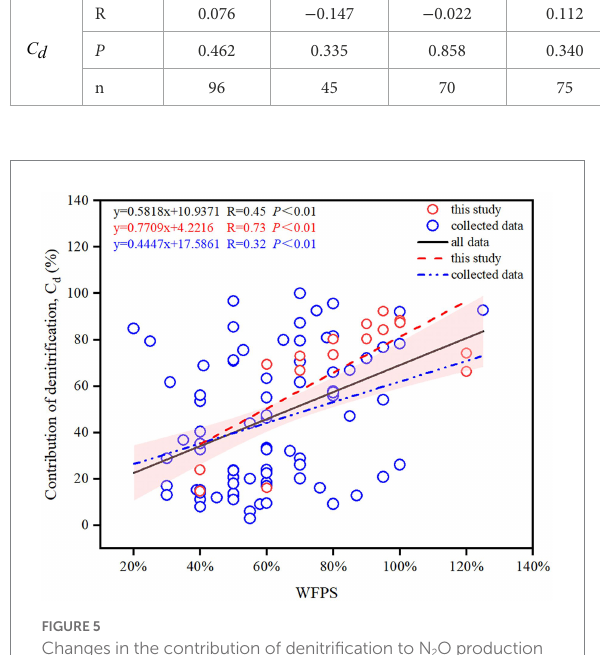
FIGURE 5 Changes in the contribution of denitrification to N 2 O production ( C d ) with WFPS across global agricultural soils. The shaded region represents the 95% confidence interval for all